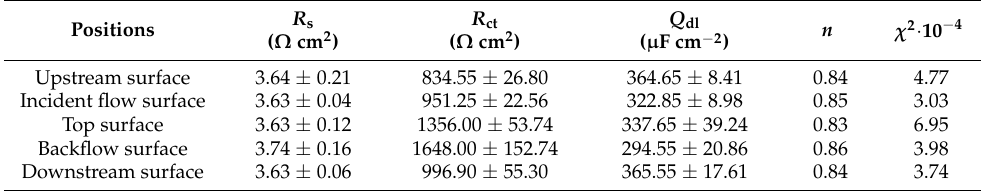
Figure 6. EIS and the fitted curves of samples in different surfaces of WRH during the corrosion in RDE with a sinusoidal alternating amplitude of 10 mV and the frequency range from 10,000 Hz to 0.1 Hz: ( a ) Nyquist plots and ( b ) Bode plots. Table 1. Equivalent circuit fitting of EIS data of each surface of the WRH.